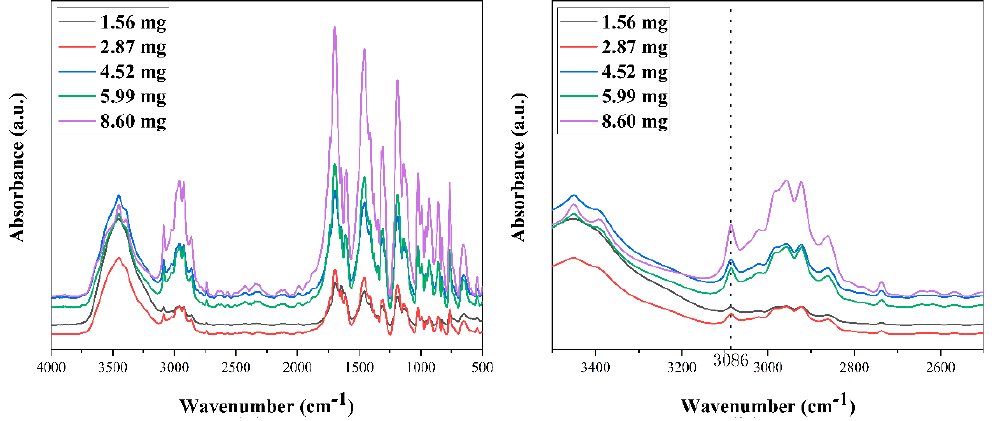
Figure 4. FTIR spectra of P/T-0.00-L samples of different amounts. Table 3. Calculation of fitting data of different amounts of P/T-0.00-L sample powders.